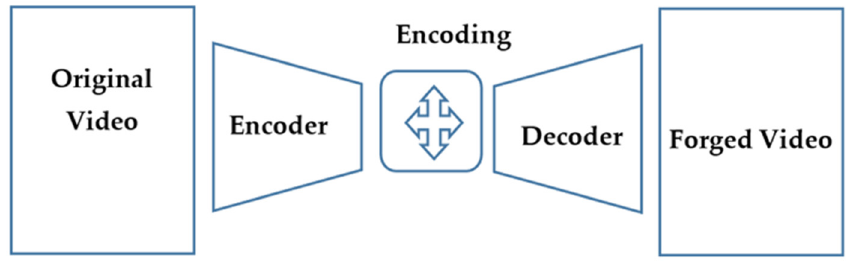
Figure 1. Forged video creation process using GAN architecture.